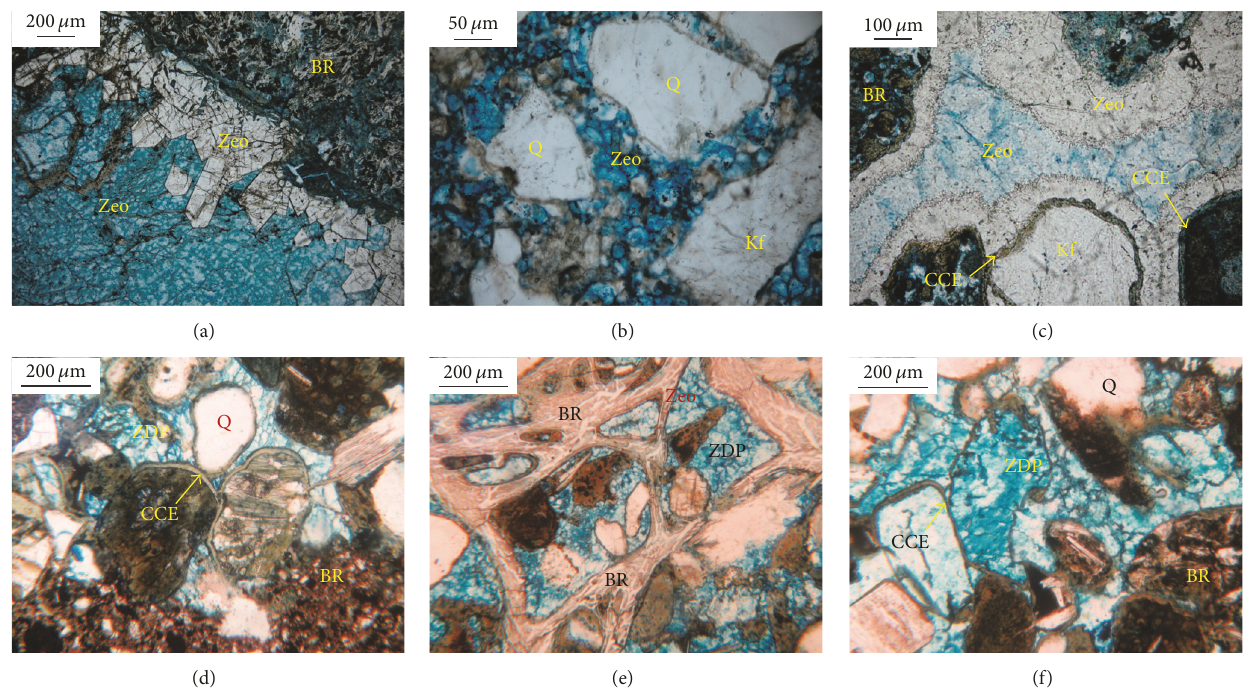
Figure 5: Photomicrographs of zeolite diagenesis and dissolved zeolite related to basalt eruption of the Paleogene sandstone reservoirs in well BZ-1. (a) Zeolite precipitated perpendicular to basalt rock fragments, E 3 d 1 , 2259 m (7411ft). (b) Zeolite filled in intergranular pores, E 3 d 1 , 2265 m (7431 ft). (c) Zeolite developed pervasively and chlorite clay envelope occurred, E 3 d, 2351 m (7713ft). (d) Micrograph of thin section showing the zeolite partly and completely dissolved and chlorite clay envelope occurred, E 3 d 1 , 2280 m (7480 ft). (e) Micrograph of thin section showing dissolved amygdaloid pores of zeolite, E 3 d 1 , 2280 m (7480 ft). (f) Micrograph of thin section showing the zeolite partly and completely dissolved, E 3 d 1 , 2280 m (7480 ft). BR = basalt rock fragments, CCE = chlorite clay envelope, Kf = K-feldspar, Q = quartz, Zeo = zeolite, and ZDP = zeolite dissolved